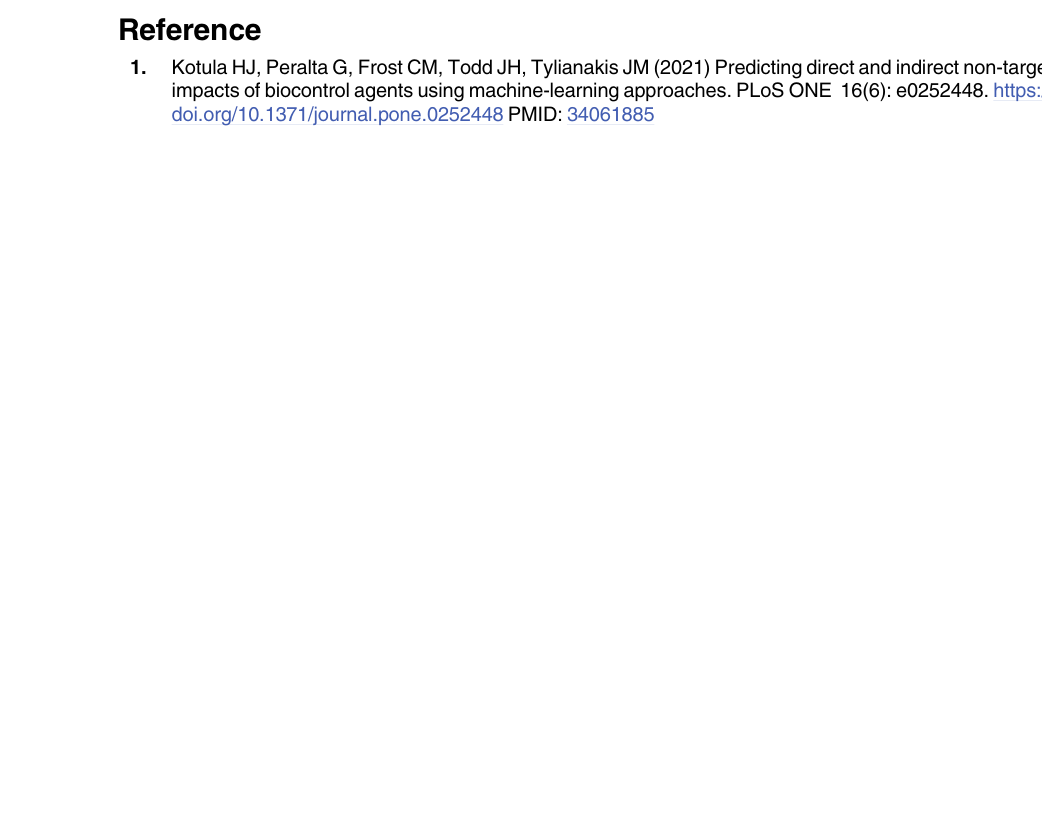
Fig 3. Overall, machine-learning predictions of observed interaction frequency varied with the generality (measured as normalised degree; ND) of the interacting partners for KNN, but not random-forest models, and depended on the abundance of the interacting partners for both models. There was a significant three-way interaction between predicted-frequency and generality of the interacting partners (host and parasitoid) in the KNN ‘native’ model. Additionally, there was a significant three-way interaction between predicted-frequency (or -probability) and abundance of the interacting partners for 4/6 models. Two are presented here to demonstrate the main patterns: (A) KNN ‘native’ model (which had a significant positive predicted frequency x host ND x parasitoid ND interaction), (B) random-forest ‘combined’ model, which had a significant host abundance x parasitoid abundance x predicted probability interaction (as did the ‘plantation’ random-forest model and the KNN ‘plantation’ and ‘combined’ models). However, the limited data between species with extreme abundance values, means this result should be treated with caution. Deviance residuals of the best-fitting model excluding the host and parasitoid ND (or abundance) variables are plotted as colour contours, to indicate whether observed interaction frequencies are higher (red) or lower (blue) than expected based on machine-learning predictions, showing how predictions vary with generality (or abundance) of the interacting partners. Each point represents a host-parasitoid species pair present within a site at the first-time step ( t ) test sites.